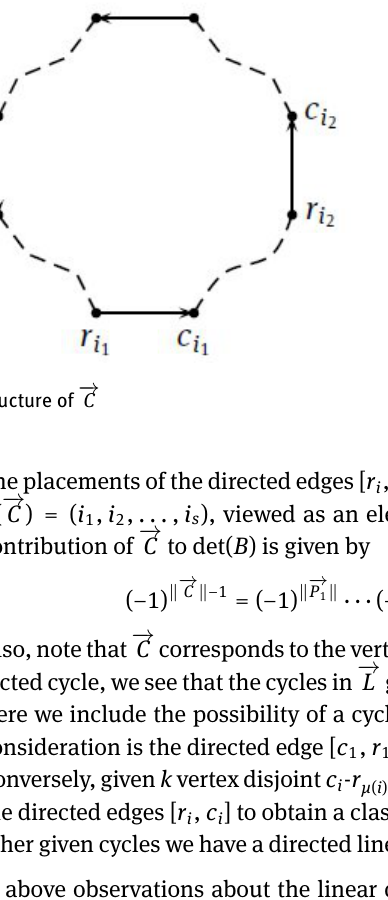
Fig. 1. Structure of